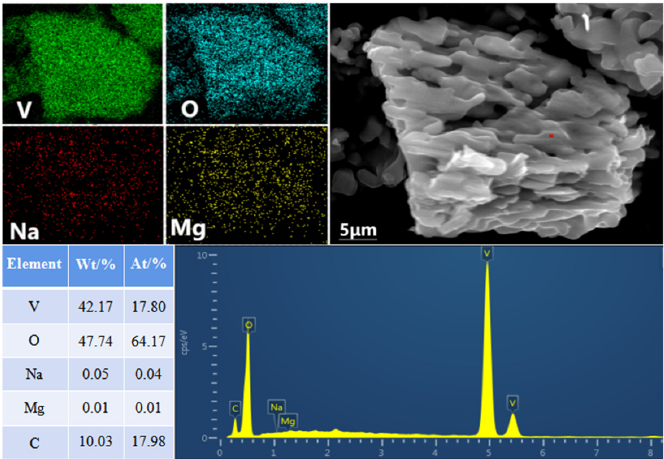
Figure 14. SEM–EDS characterization of V 2 O 5 obtained